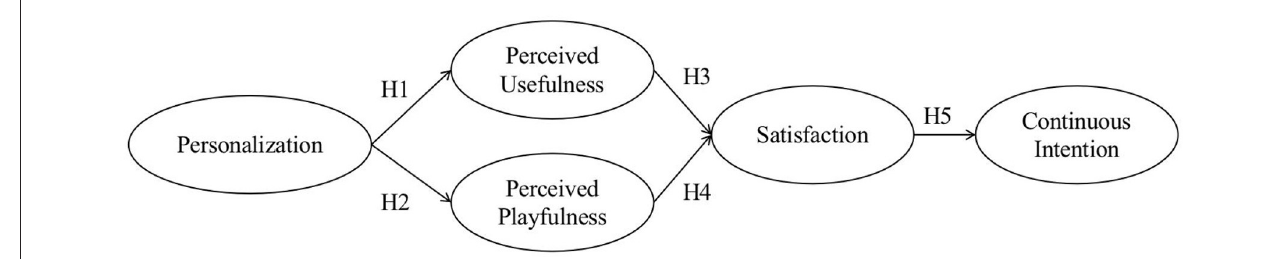
FIGURE 1 | Model of undergraduates’ continuance intention of using the e-book